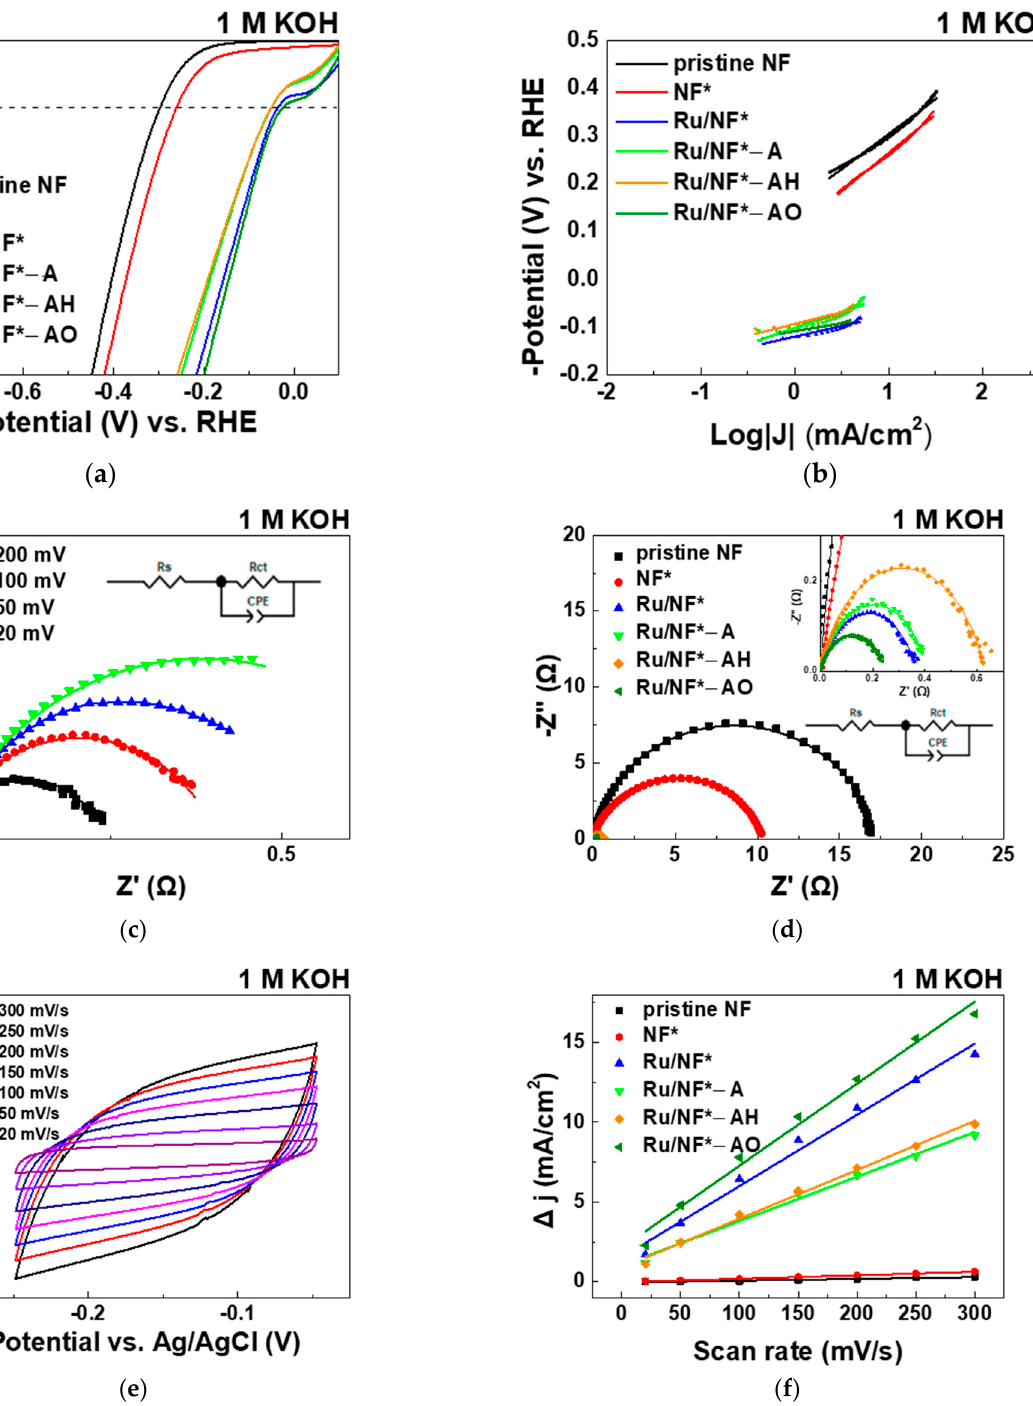
Figure 5. In 1 M KOH aqueous solution: ( a ) LSV polarization curves of pristine NF, NF*, Ru/NF*, Ru/NF*-A, Ru/NF*-AH, and Ru/NF*-AO catalysts toward HER. ( b ) Corresponding Tafel plots of HER. ( c ) Nyquist plots of Ru/NF*-AO catalyst at four different applied overpotentials versus RHE. ( d ) Nyquist plots of pristine NF, NF*, Ru/NF*, Ru/NF*-A, Ru/NF*- AH, and Ru/NF*-AO catalysts at an overpotential of 200 mV versus RHE. ( e ) CV potential curves of Ru/NF*-AO at different scan rates. ( f ) Current density of various electrocatalysts as a function of scan rate. Table 2. Corresponding parameters of electrocatalyst in 1M KOH as calculated from Figure 5.